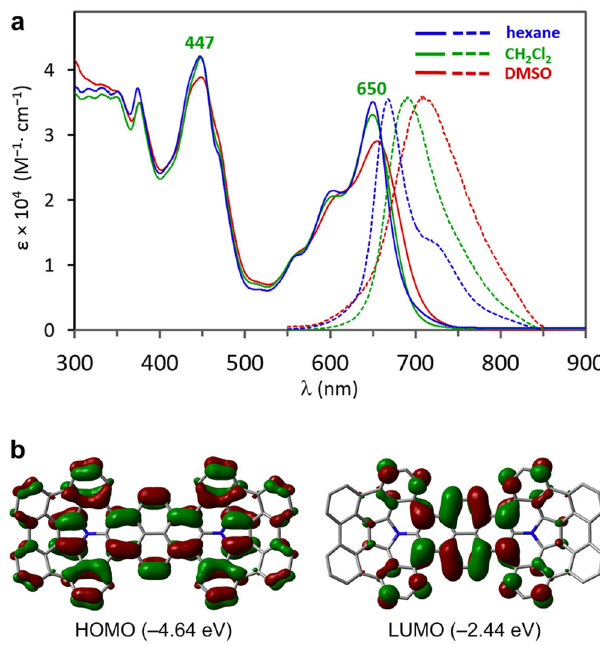
Fig. 5 Optical Properties of azacorannulene dimer 4. a UV/Vis absorption spectra (1.0 × 10 − 6 M, solid lines) and emission spectra (1.0 × 10 − 5 M, dashed lines) of 4a in hexane (blue), dichloromethane (green), and dimethyl sulfoxide (red). b HOMO and LUMO of 4b .